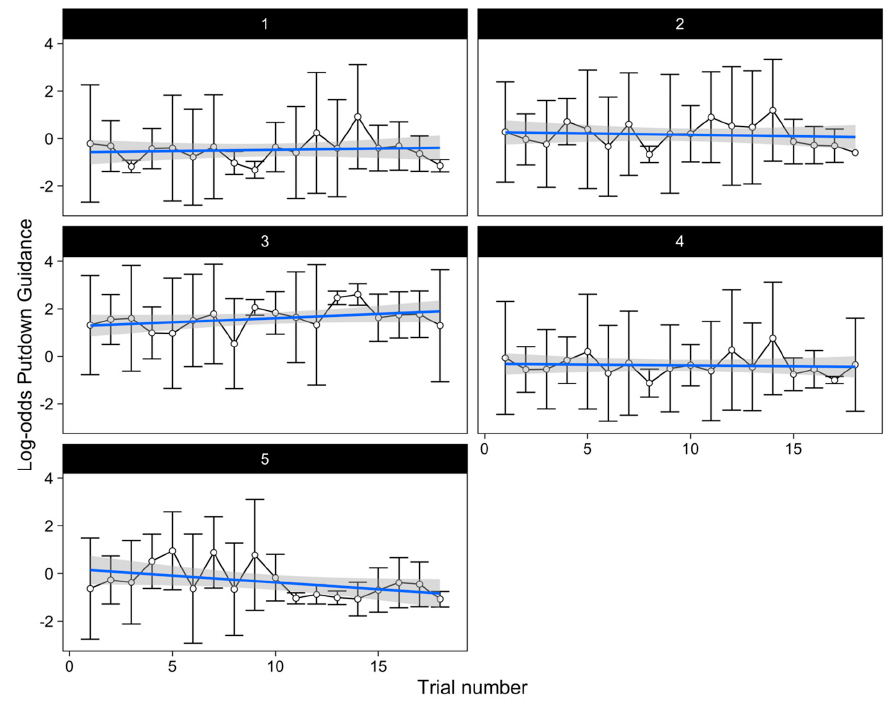
Figure A2. Log-odds plots of putdown 1 guidance with 95% CI across trial number, with panels representing each participant.